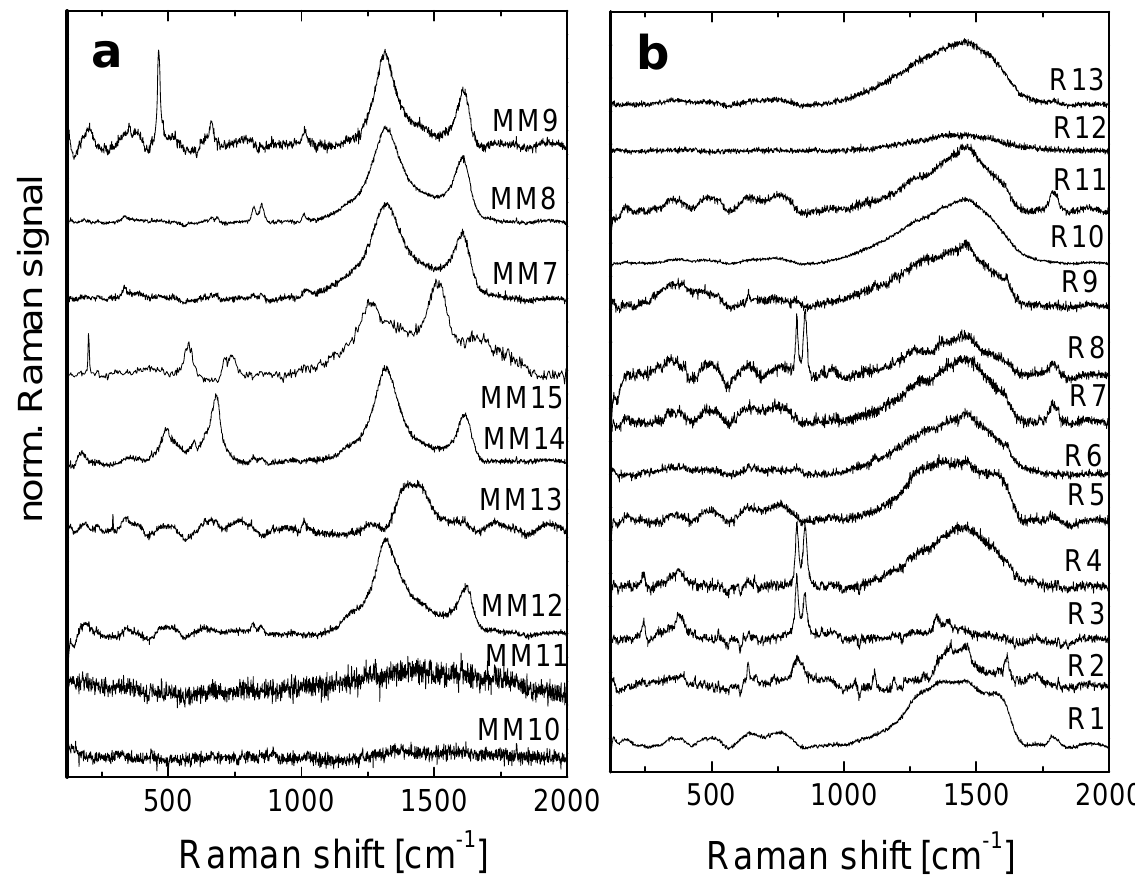
Figure 5. Series of Raman spectra of Mező-Madaras (MM) (a) and Mócs (R) (b) meteorites. MM is dominated by two broad peaks located around 1320 cm −1 and 1610 cm −1 . These peaks correspond to the so called D and G bands of hydrogenated amorphous carbons, respec- tively. Mócs is also dominated by a broad feature in the above mentioned region. However, in this case a broad, asymmetric peak can be seen instead of the two well-distinguishable peaks, which can be decomposed into two sub-bands by fitting with Gaussians. The broad peak also corresponds to amorphous carbon, but this phase differs remarkably from that in the MM sample. Decomposition shows the G peak position to be close to 1520 cm −1 , a value characteristic for hydrogenated amorphous carbon with sp2 carbon atoms arranged mostly into chains. An additional peak can be seen around 1580 cm −1 , corresponding to the sp2 C=C stretching vibrations of aromatic rings. A carbonyl peak can also be observed, which could imply the presence of oxygen in the amorphous carbon structure (SI